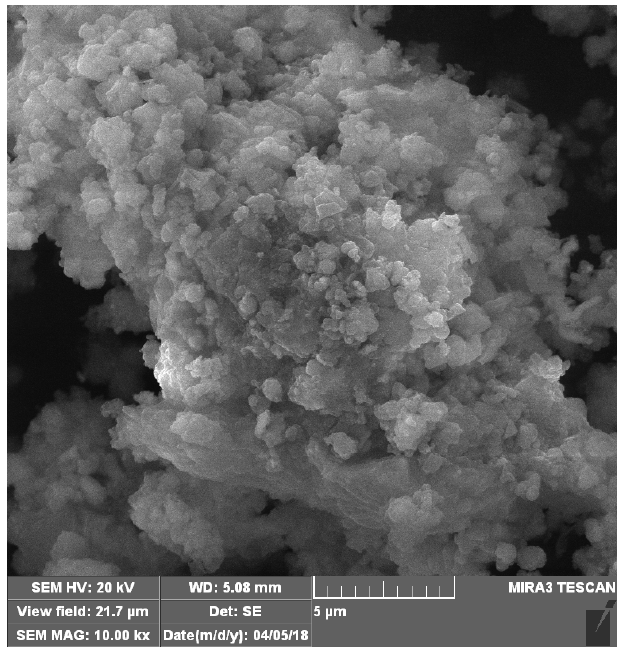
Figure 9. SEM micrograph of reduced Au particles.